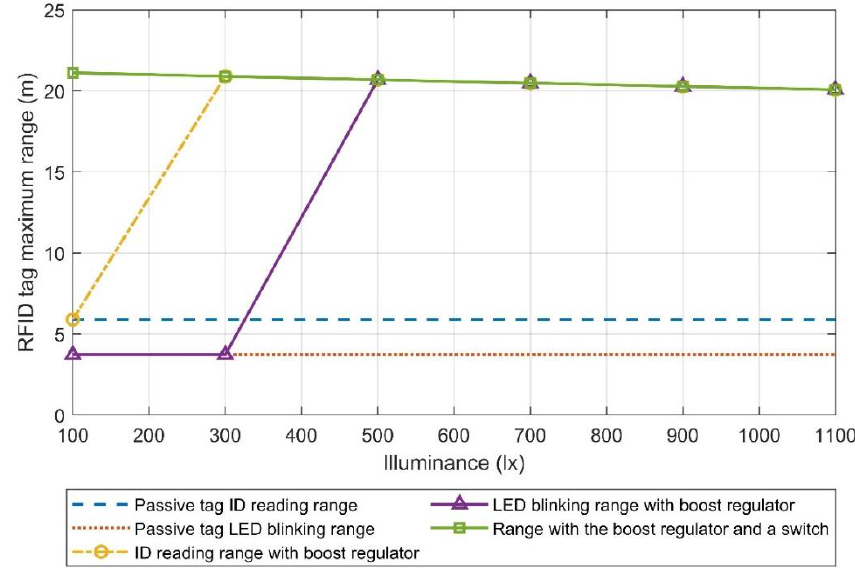
Figure 16. Maximum tag ID reading range and LED blinking range of the RFID tag with the photovoltaic harvesting system proposed in Figure 9b, when connecting the tag directly to the output of the boost regulator and when doing it through a switch. Table 4. State-of-art (SoA) of RFID sensors and actuators with a solar harvester.